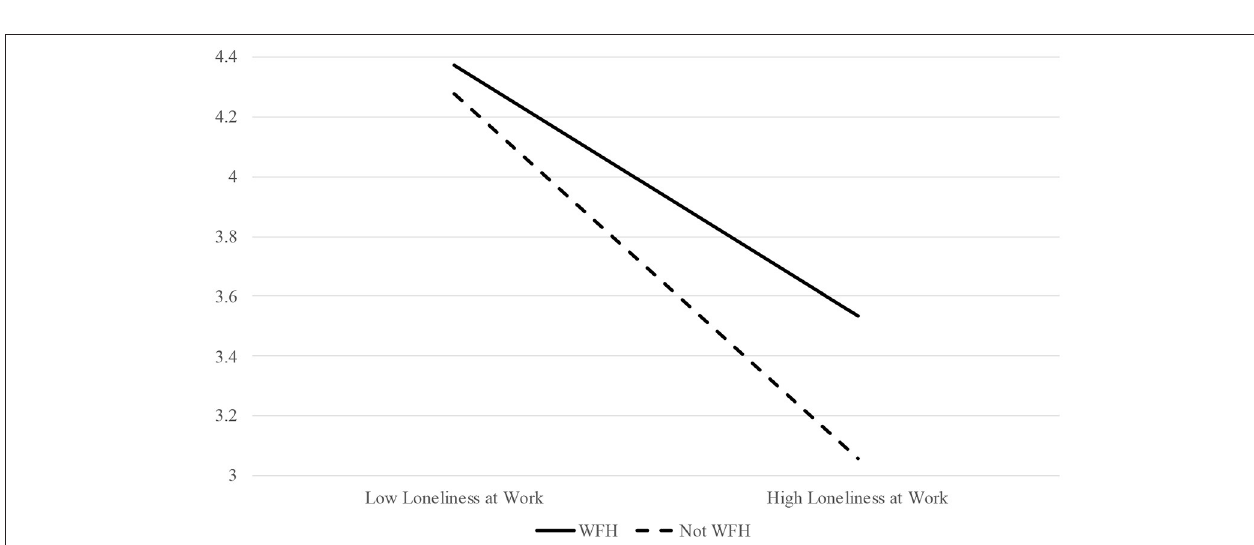
FIGURE 3 | The interactive effect of workplace loneliness and working from home (WFH) on perceived coworker